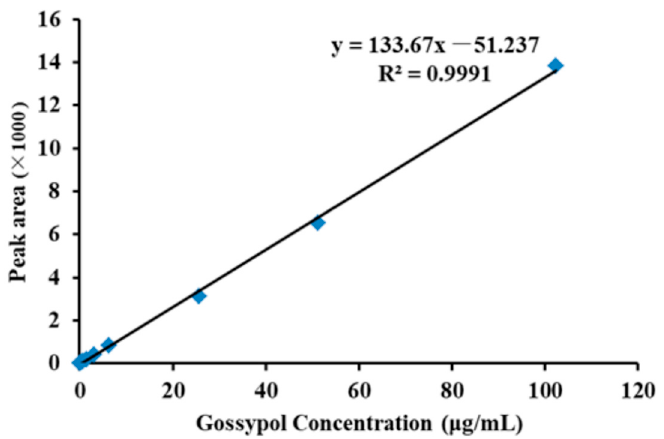
Figure 1. Standard curve of gossypol.